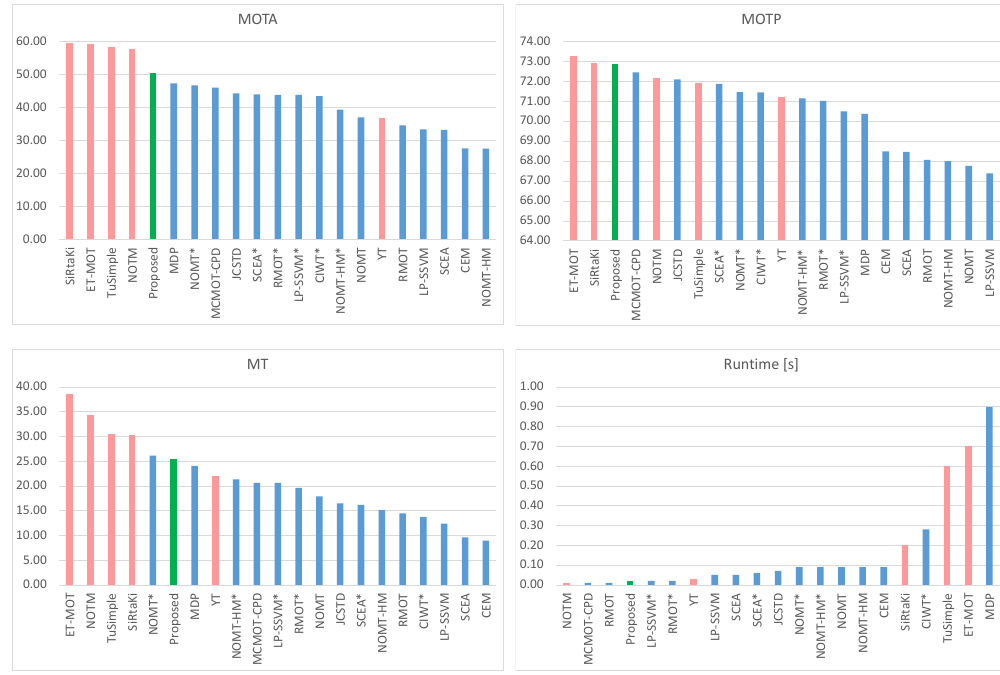
Figure 8. Comparison of the proposed method with various evaluated Pedestrian trackers on the KITTI tracking test set. Red indicates trackers with unknown source, blue bars are trackers published in the literature and green bars are results from the proposed tracker. Higher MOTA, MOTP and MT scores are